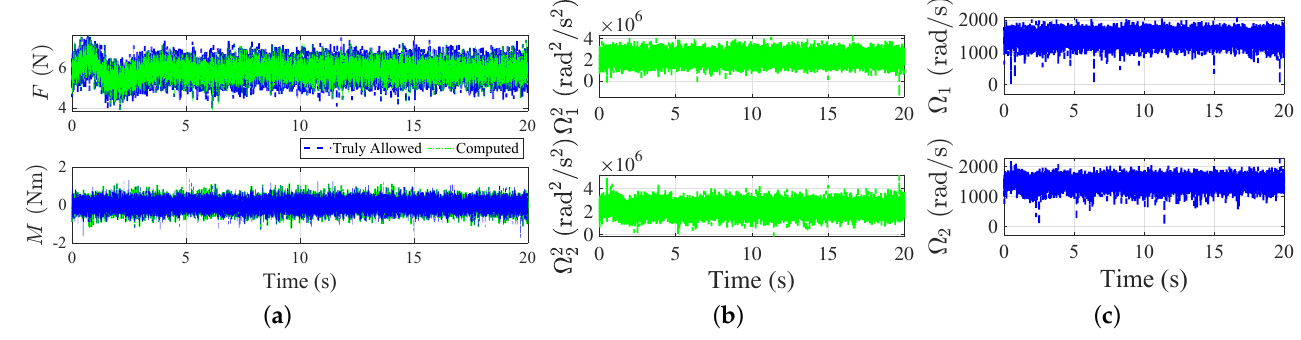
Figure 9. Comparison of computed and truly allowed controls and rotor speeds for the proposed AIBC. ( a ) comparison of the computed and truly allowed controls (AIBC); ( b ) square of computed rotor speeds; ( c ) truly allowed rotor